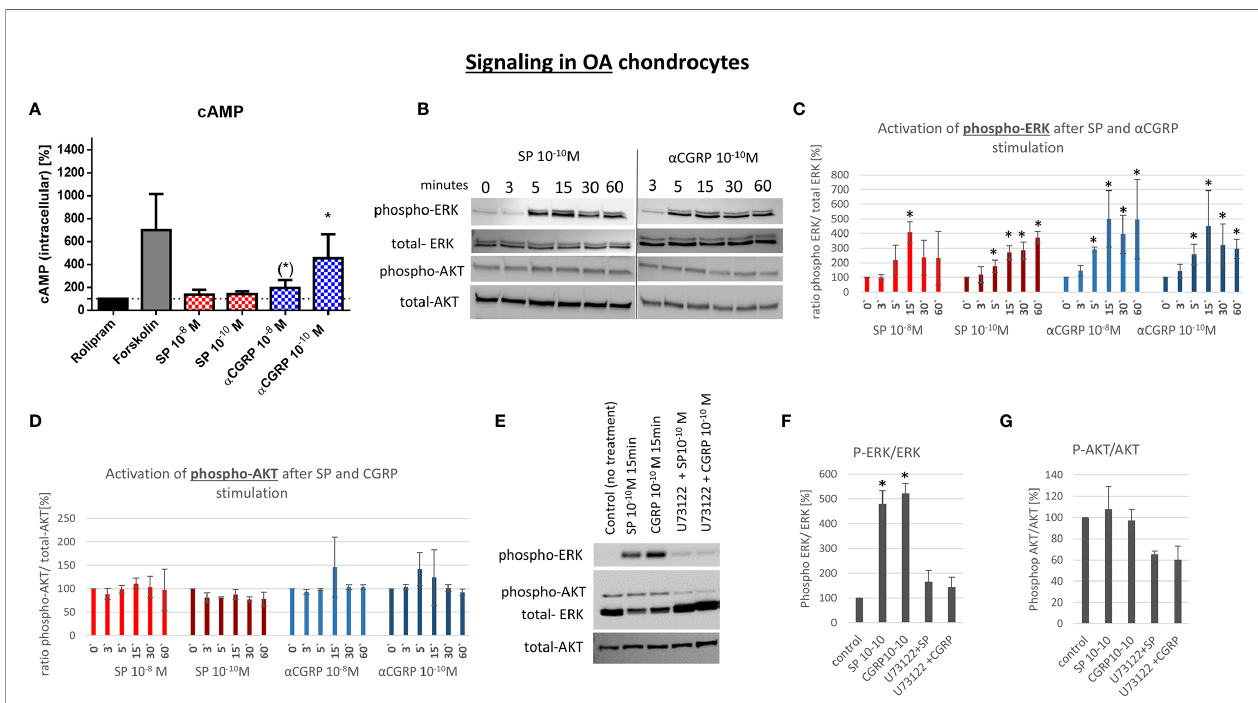
FIGURE 7 | Effect of SP and a CGRP on signaling in OA chondrocytes. Chondrocytes were treated with either 10 -8 or 10 -10 M SP or a CGRP for 3, 5, 15, 30 and 60 minutes, and then compared to the respective untreated control cells. (A) Level of cAMP was detected via ELISA. Cells were pre-incubated with Rolipram (phosphodiesterase 4 inhibitor) to avoid cAMP degradation, and then treated with SP, a CGRP or Forskolin (positve control for cAMP induction). The graph shows the relative amount of cAMP in relation to Rolipram-incubated cells (dotted line=100%) in OA chondrocytes. n = 3. (B) Representative Western Blot images for phospho-ERK1/2 (~ 44/42 kDa), ERK1/2 (~44/42 kDa), phospho-AKT (~60 kDa) and AKT (~60 kDa) protein concentration after 0, 3, 5, 15, 30 and 60 minutes of stimulation in OA chondrocytes. (C, D) Ratio of phospho-ERK1/2 to total-ERK1/2 and phospho-AKT to total-AKT protein expression was determined densitometrically. Expression w/o stimulation (0 ’ ) served as 100% control, n = 3. (E) Representative Western Blot images of U73122 (= phospholipase C inhibitor) treated OA chondrocytes to verify G alpha q mediated AKT- and ERK1/2-signaling. (F, G) Ratio of phospho-ERK1/2 to total-ERK1/2 and phospho-AKT to total-AKT protein expression was determined densitometrically. Expression w/o stimulation served as 100% control, n = 3. Results are means +/- SD; one sample t-test, (*) p = 0,065; *p <